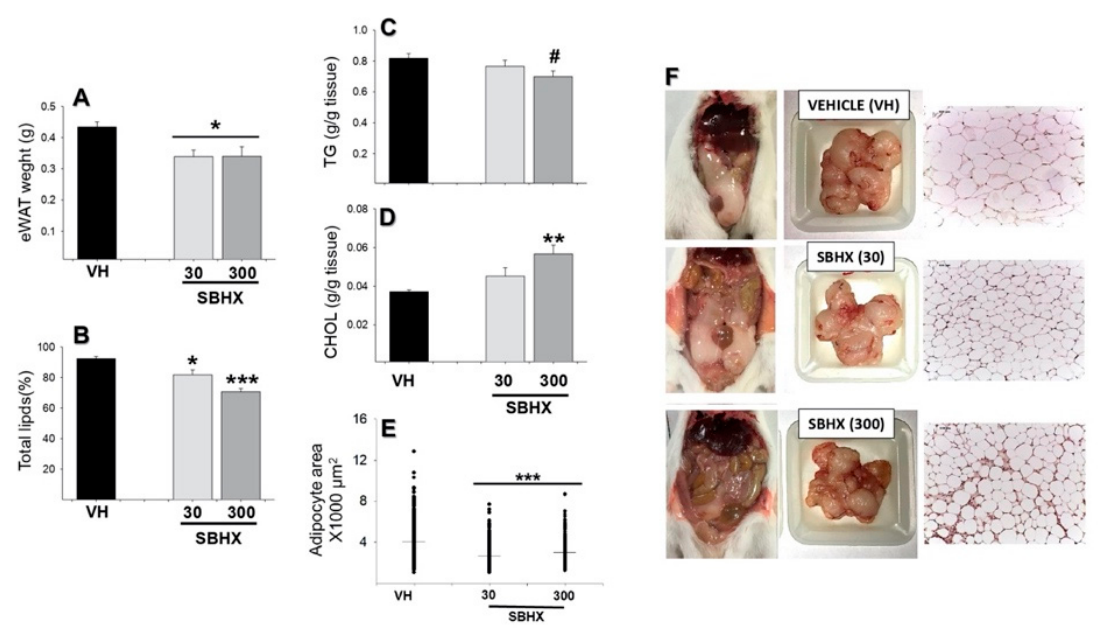
Figure 4. Histological and biochemical analysis of epididymal white adipose tissue (eWAT) of mice receiving SBHX (30 or 300mg/kg, i.p.) and compared to the vehicle group (VH). eWAT weight (g) ( A ), total epididymal lipids (%, determined by the Folch method) ( B ), epididymal triglycerides (g TG/g tissue) ( C ), epididymal cholesterol (g CHOL/g tissue) ( D ), and adipocyte area ( × 1000 µ m 2 ) ( E ). Representative images of abdominal fat, epididymal adipose tissue after being removed, and adipocytes taken with a light-field microscope with 40 × magnification ( F ). Data represent the mean ± SEM of five mice ( n = 5) or the median in panel ( E) . * p <0.05, ** p < 0.01 or *** p < 0.001, ANOVA followed by Dunnett’s test. # p < 0.05, Student’s t